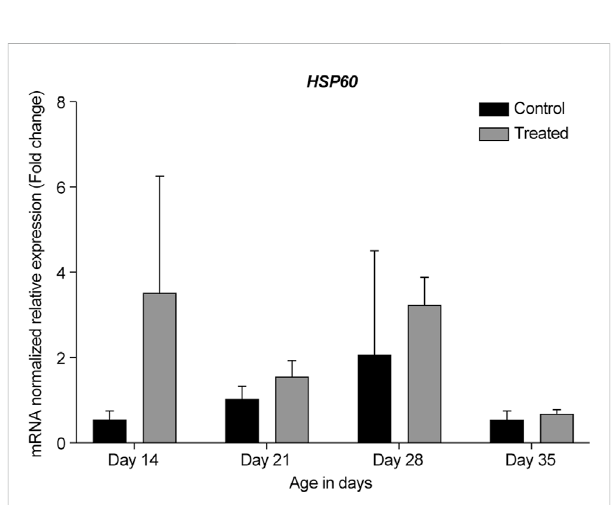
FIGURE 8 ΔΔ Ct oftherelativenormalizedexpressionfor HSP60 inthecontrol (indoor) group and heat-treated (outdoor) chickens at 14-, 21-, 28-, and 35-days of age in the summer of 2021 ( n = 3 in each group). HSP, heat shock